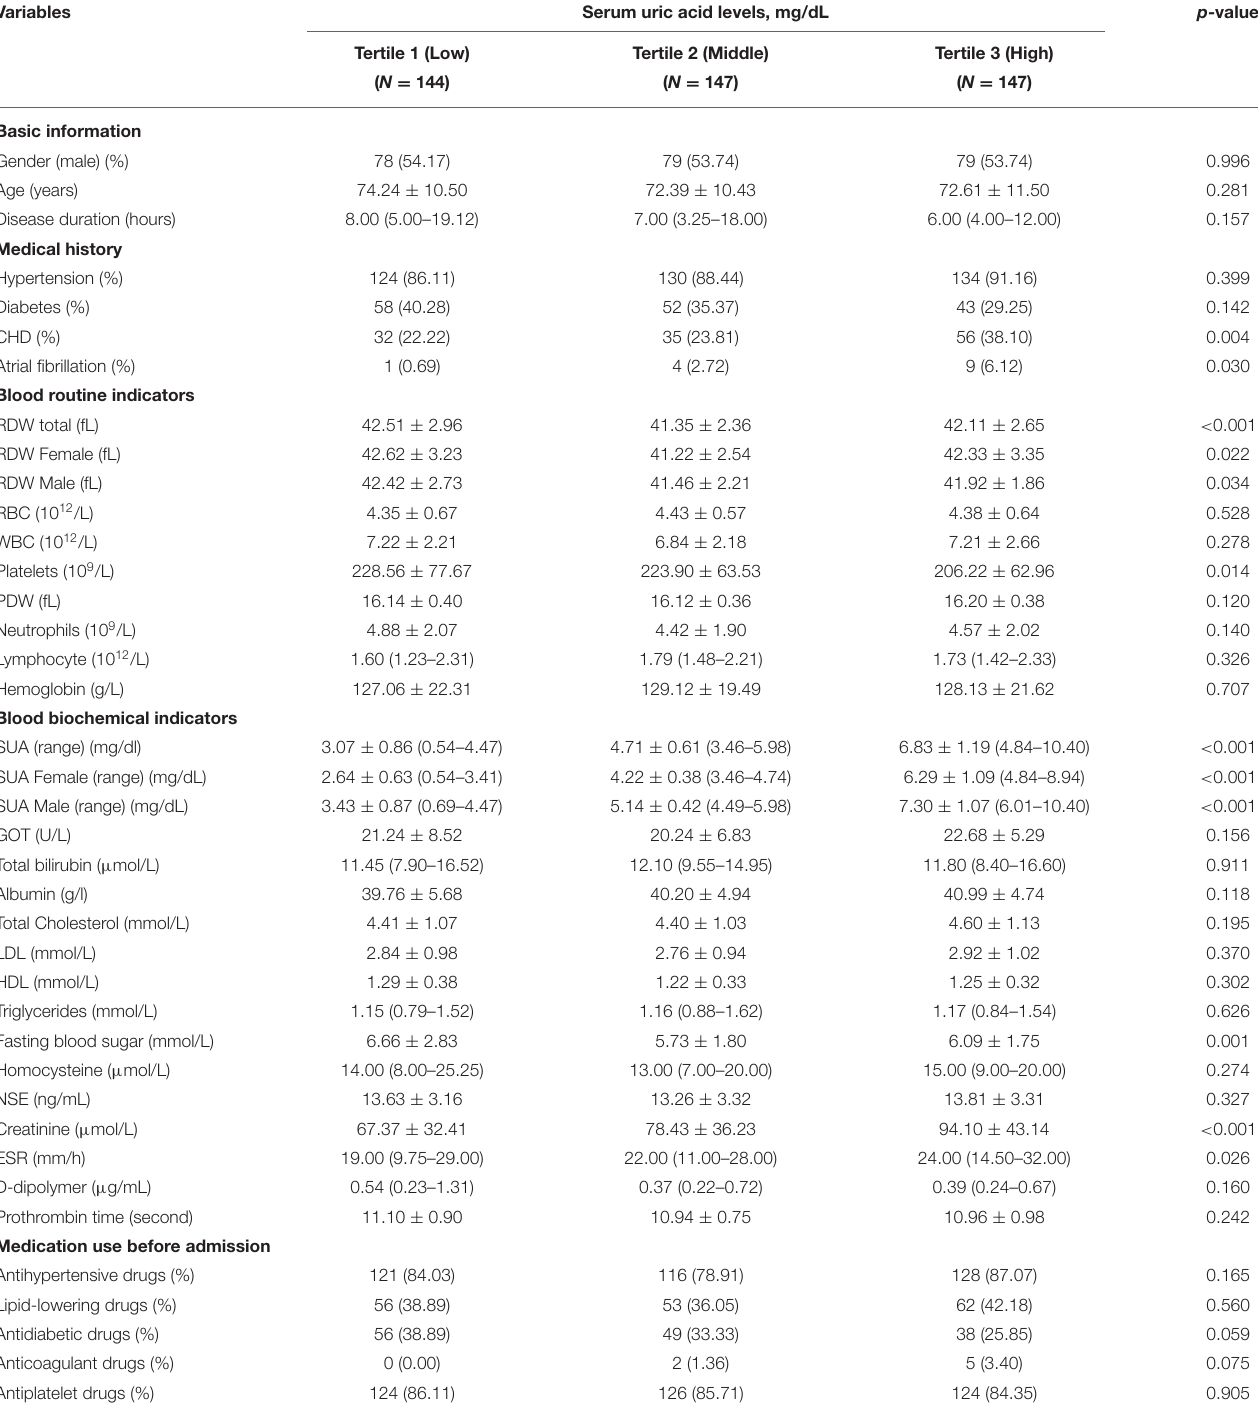
TABLE 1 | Baseline characteristics of participants by the tertiles of SUA level.